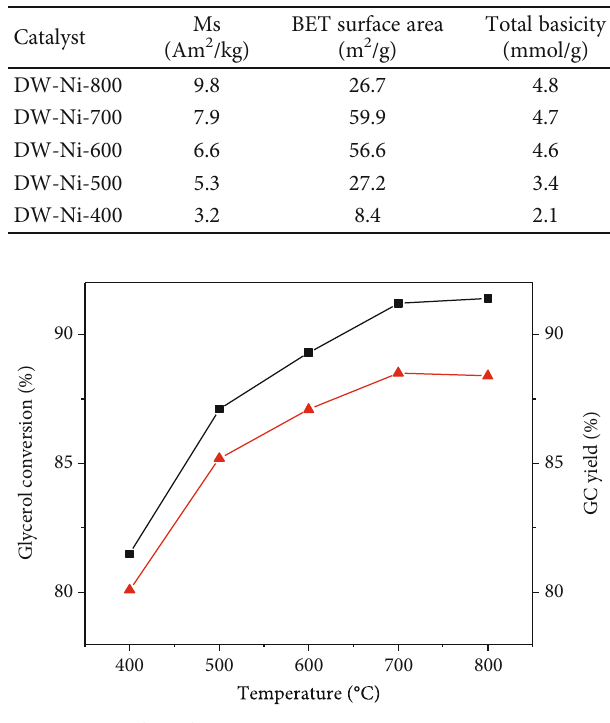
Figure 4: Hysteresis loop of the catalysts prepared at di ff erent calcination temperatures. Table 1: Physicochemical properties of catalysts prepared at di ff erent calcination temperatures.